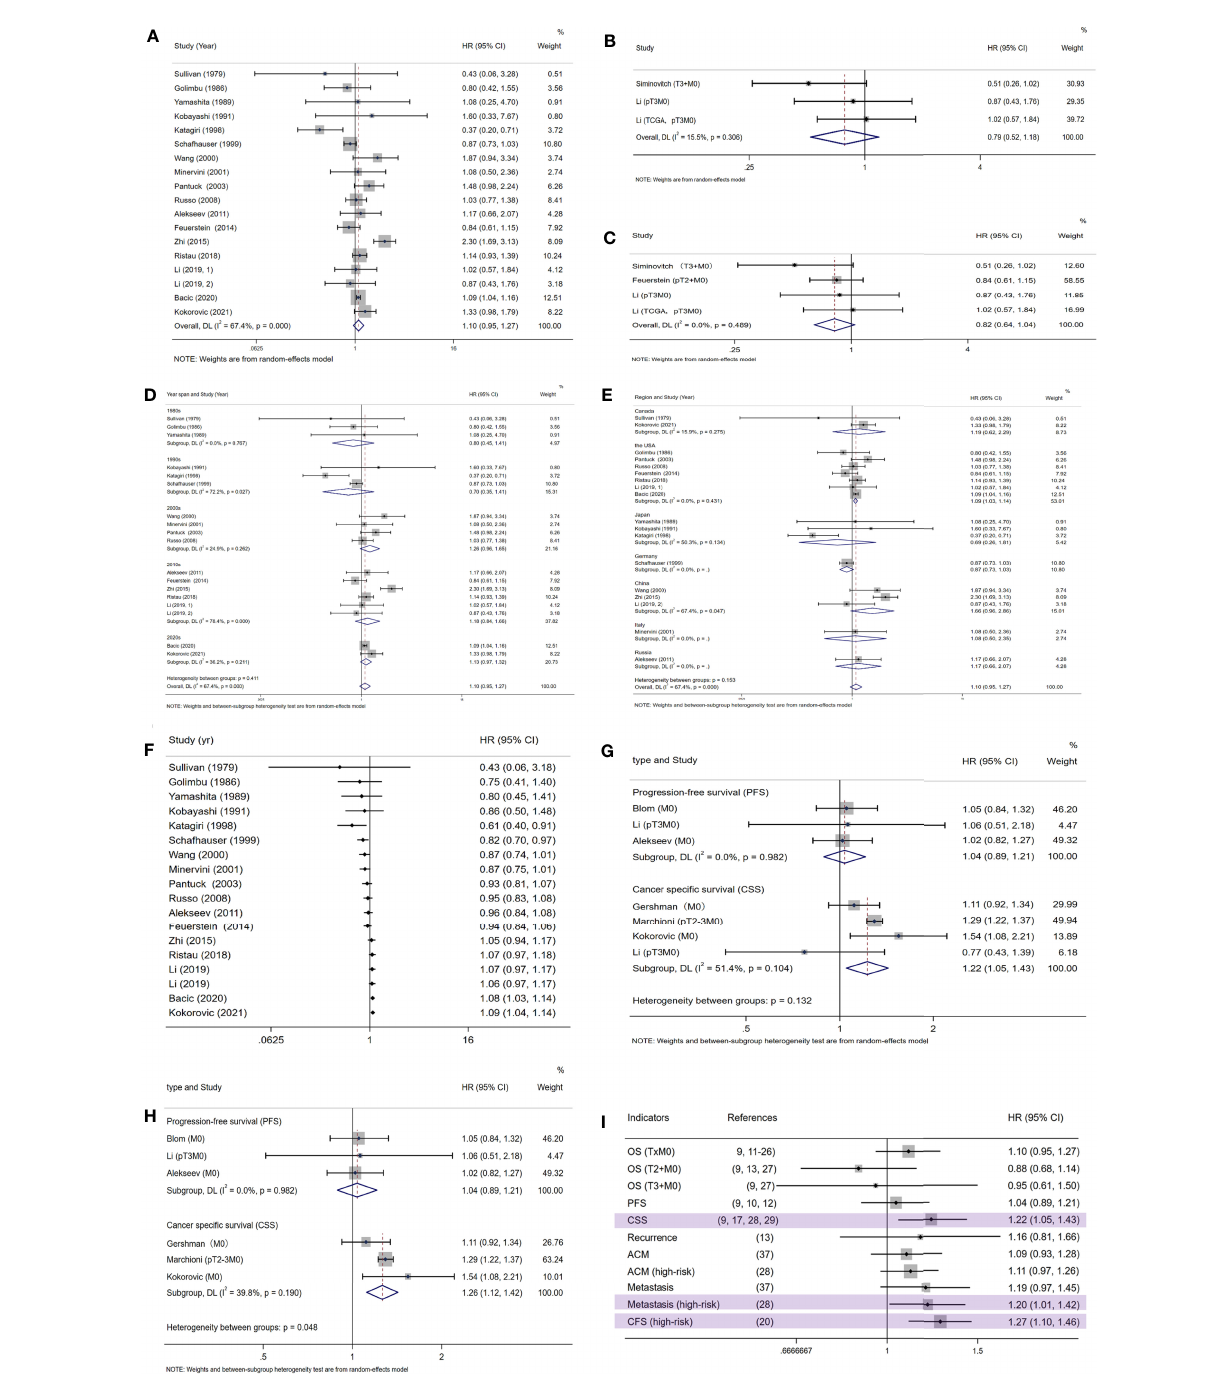
FIGURE 2 | The meta-analysis results of survival outcomes with OS\PFS\CSS as indicators; (A) the meta-analysis result of RCC patients ’ OS; (B) the meta- analysis result of OS of T3+M0 RCC patients; (C) the meta-analysis result of OS of T2+M0 RCC patients; (D) subgroup analysis according to the 10-year year span; (E) subgroup analysis according to the country where the research was carried out; (F) cumulative Meta analysis on OS; (G) the meta-analysis results of RCC patients ’ PFS and CSS; (H) the results of PFS and CSS, with the literature of Li et al. excluded; (I) a summary table for evaluating the impact of LND on the prognosis of RCC patients with different survival indicators; OS, overall survival; PFS, progression-free survival; CSS, cancer speci fi c survival; ACM, all-cause mortality; CFS, cancer-free